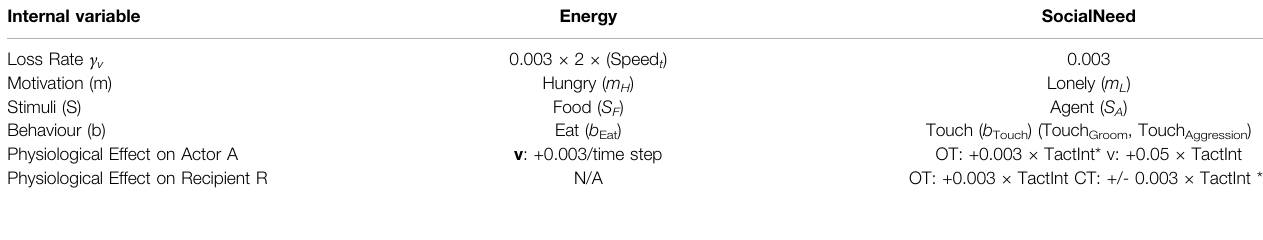
Frontiers in Robotics and AI |